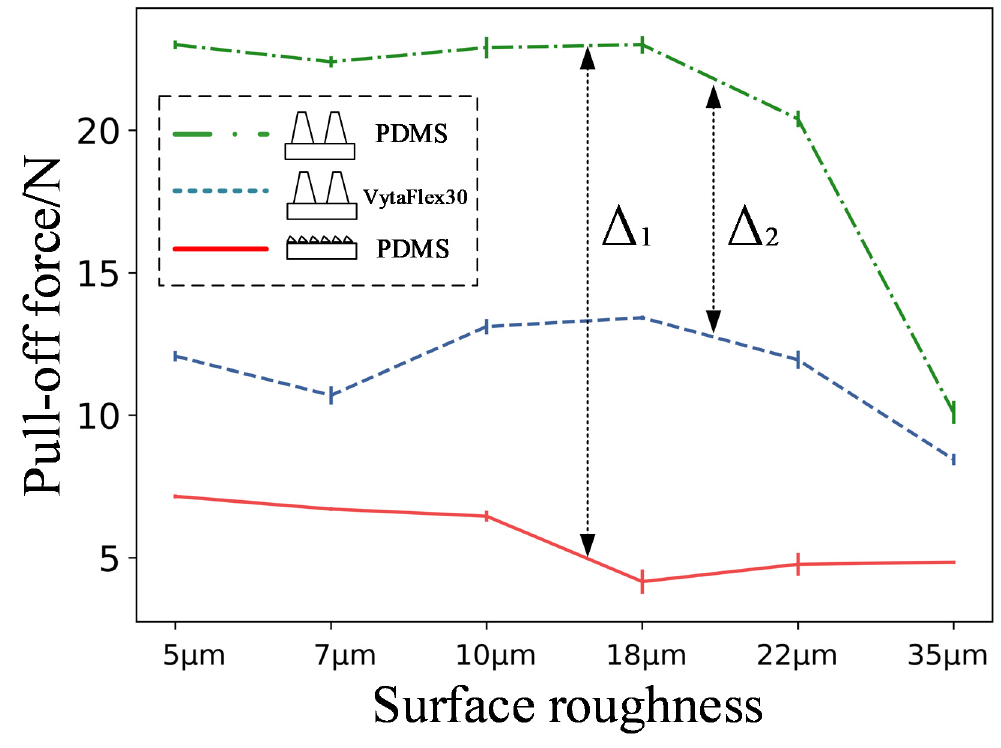
Figure 8. Effect of the material and microstructure shape on the pull-off force.